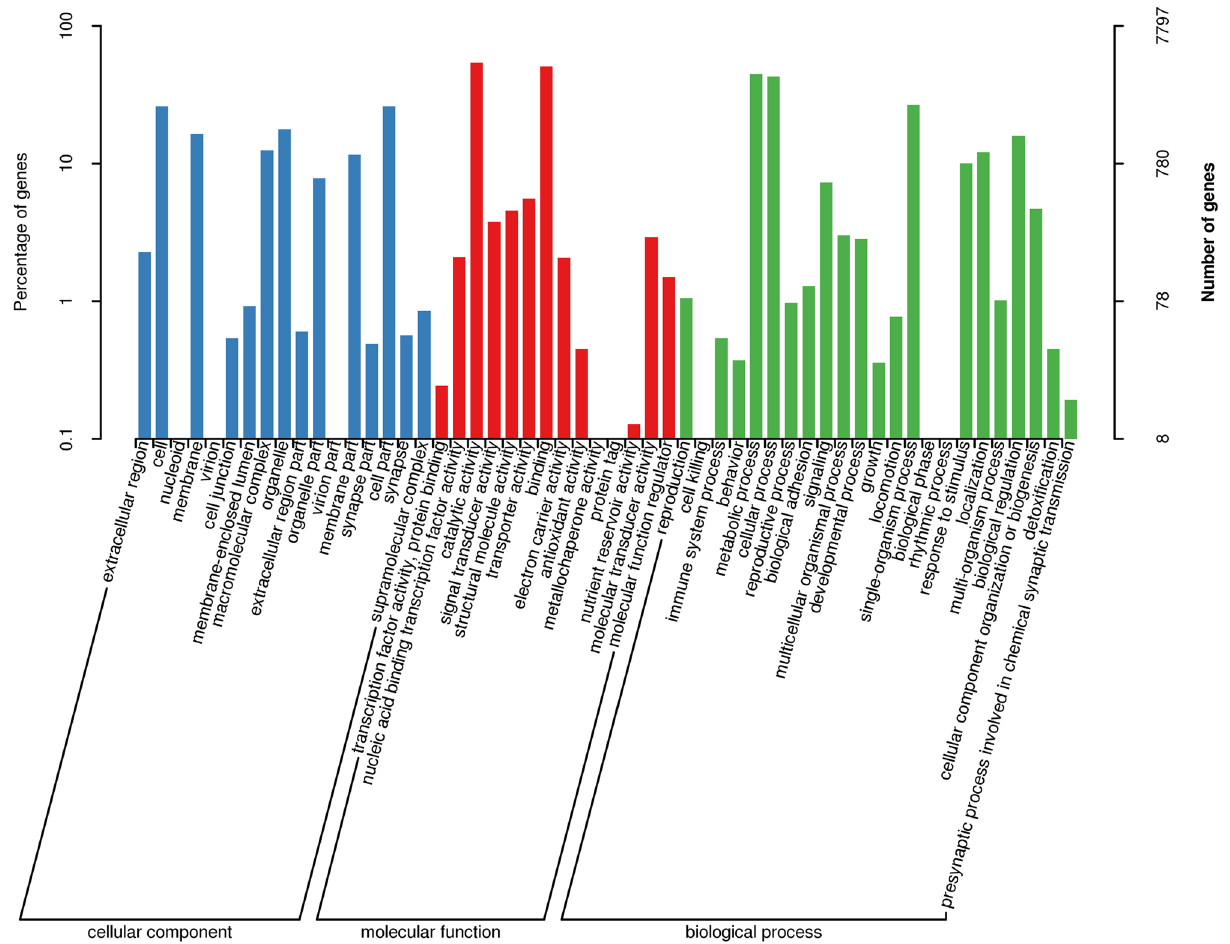
Figure 2. Gene Ontology (GO) classifications of Athetis dissimilis reproductive organs unigenes according to their involvement in biological processes, cellular component and molecular